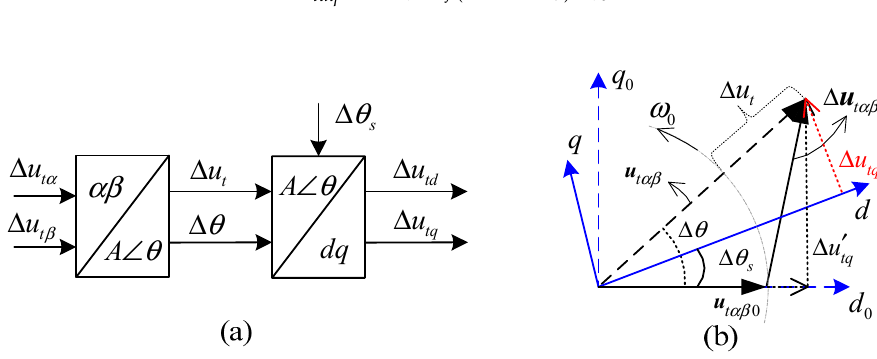
Figure A1. Small-signal variable in SRF-PLL: ( a ) the diagram description of the linearization of the coordinate transformation in SRF-PLL; and ( b ) small-signal space vector relations between different frame references.